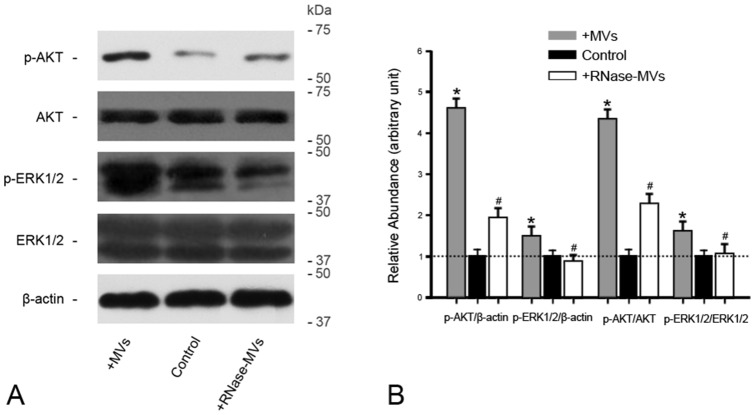
MVs induce the activation of AKT and ERK1/2 signaling in tumor tissues.
(A)(B) Gel photograph and densito-metric analysis of of AKT, p-AKT, ERK1/2 and p-EREK1/2 protein expression in inoculated tumors. MVs led to a significant phosphorylation of tumor AKT and ERK1/2 proteins. The density of each band was determined. Values in the graph are expressed as densitometry ratios of p-AKT/β-actin, p-ERK1/2/β-actin, p-AKT/AKT or p-ERK1/2/ERK1/2 as folds over control (dotted line). *P<0.05, MVs vs. control; #
P<0.05, RNase-MVs vs. MVs.